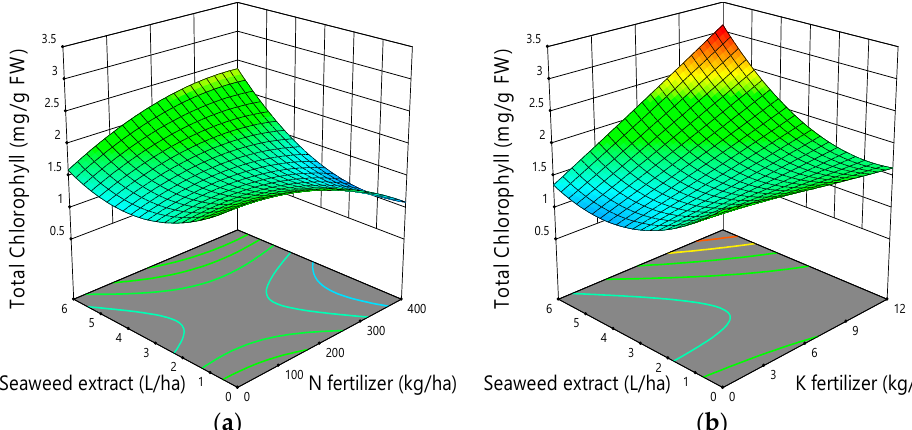
Figure 1. Response surface plots showing the effects of N fertilizer and seaweed extract ( a ), and K fertilizer and seaweed extract ( b ) on the total chlorophyll content of thyme. K fertilizer in ( a ), and N fertilizer in ( b ) was kept constant at 6 and 200 kg ha − 1 , respectively.